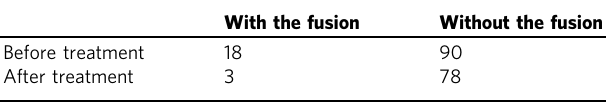
The Fisher ’ s exact test (two-sided) gives a p -value of